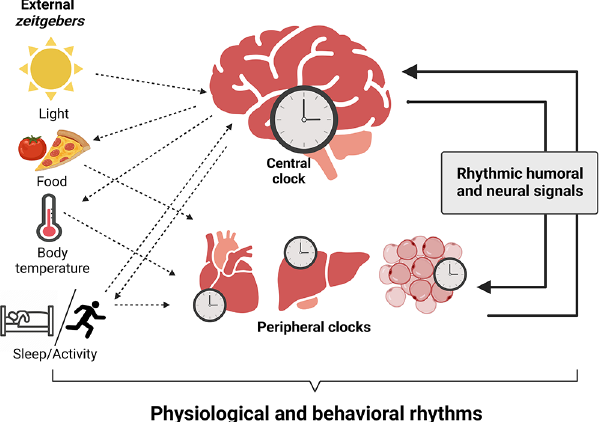
Figure 1. Organization of the circadian system in mammals. The primary zeitgeber , light, entrains the master pacemaker, the suprachiasmatic nucleus (SCN), with geophysical time. The SCN synchronizes subordinated central nervous system (CNS) and peripheral tissue clocks by humoral and neural signals and the temporal coordination of food intake, body temperature, and rest/activity cycles. Outputs of peripheral tissues feedback to clocks in the brain and stabilize circadian synchrony. Integration of external signals, collective output of tissue clocks, and rhythmic humoral and neural signals generates physiological and behavioral circadian rhythms. Figure created with